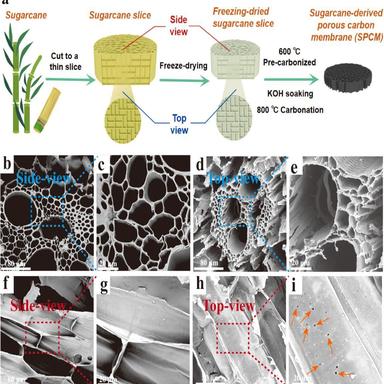
(a) A diagram illustrating the manufacturing process for SPCM. (b, c) The microstructures with the side view of the freezing-dried sugarcane slices, and (d, e) the top view. (f, g) The microstructures with the side view of the SPCM electrodes, and (h, i) the top view.